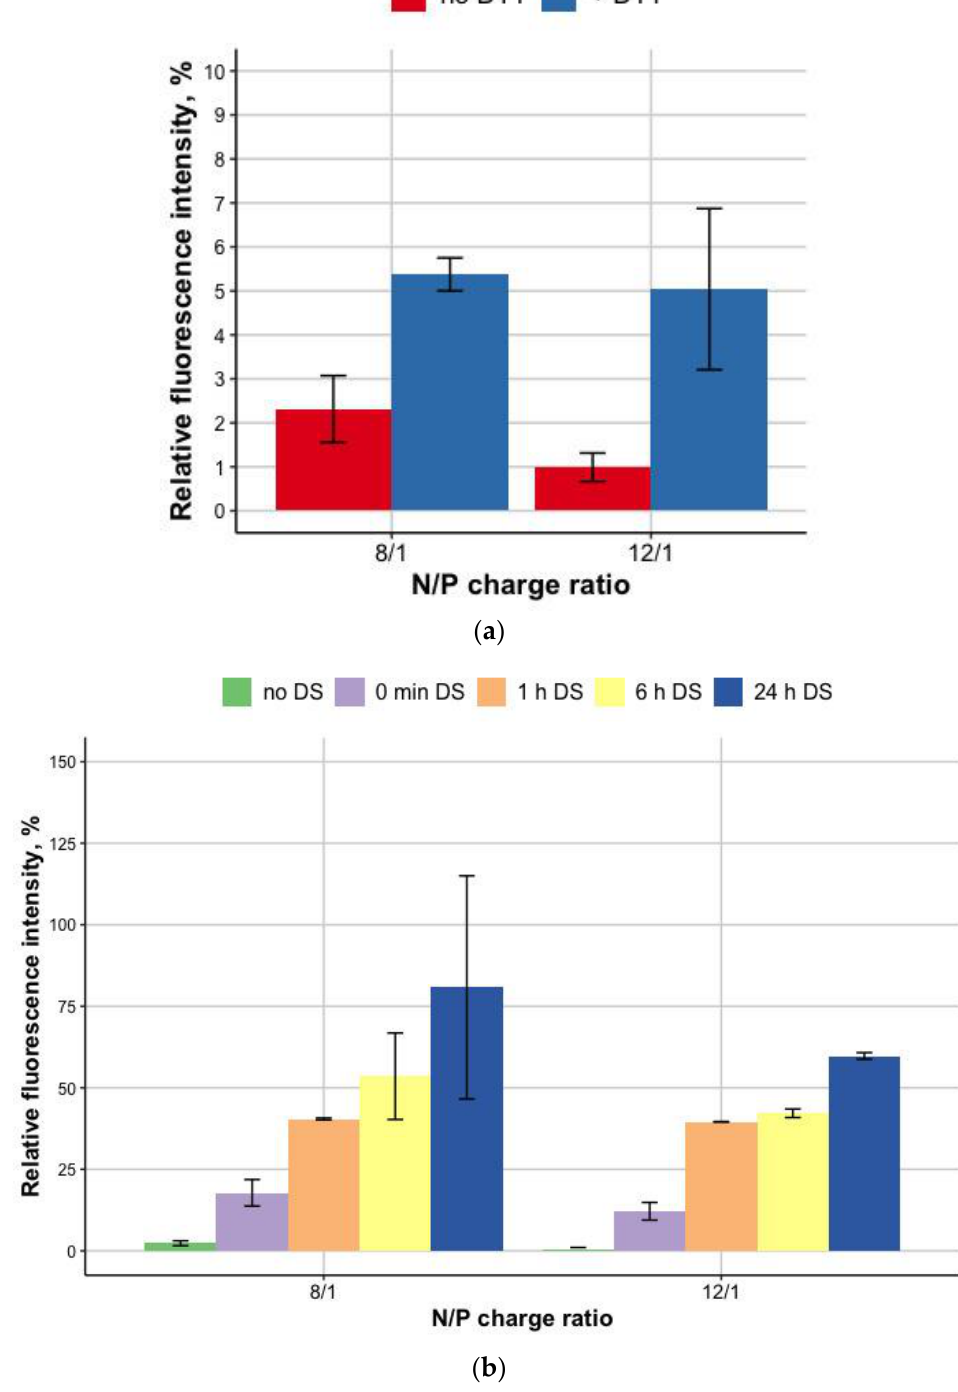
Figure 3. DNA release after ( a )DTT treatment of R6p-cRGD/DNA/MNPs polyplexes; ( b ) relaxation of R6p-cRGD/DNA/MNPs polyplexes after 24h of DS treatment in three-fold charge excess. Values are the mean ± SD of the mean of triplicates.